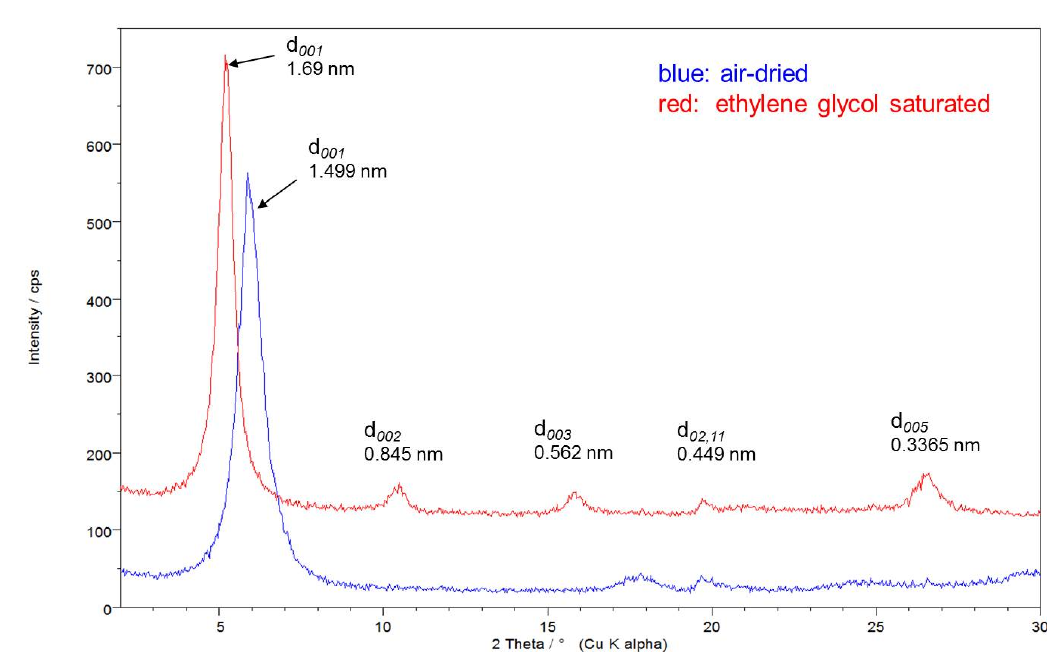
Figure 12. X-ray diffraction patterns of sample Jal 11 (oriented slide, air-dried and saturated by ethylene glycol, y-offset 100 cps); the pattern in ethylene glycol saturated state shows full swelling and a rational series of basal reflections of dioctahedral smectite.